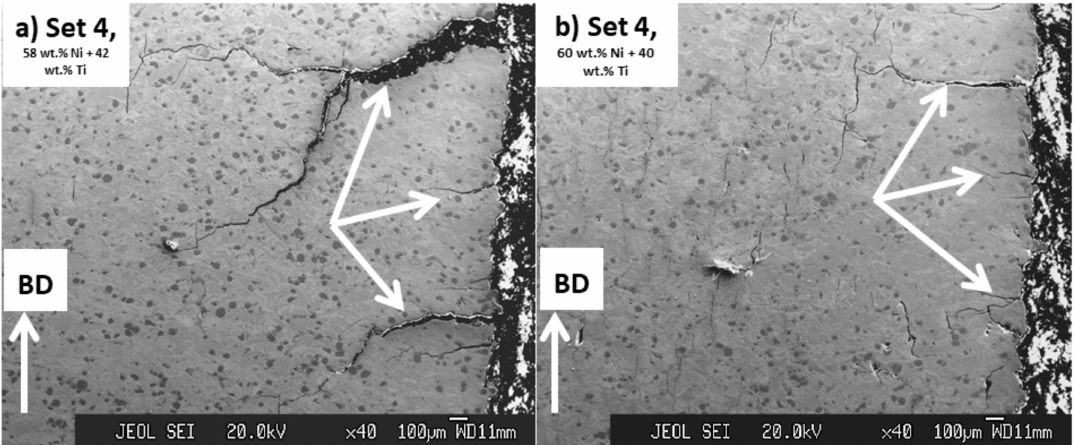
Figure 5. Images obtained from the cross-section of samples processed by processing set 4 having energy input of 39.68 J/mm 3 , from powder mixtures having ( a ) 58 wt.% Ni + 42 wt.% Ti and ( b ) 60 wt.% Ni + 40 wt.% Ti compositions. Some of the cracks seen in the corners of these samples are shown by arrows in the